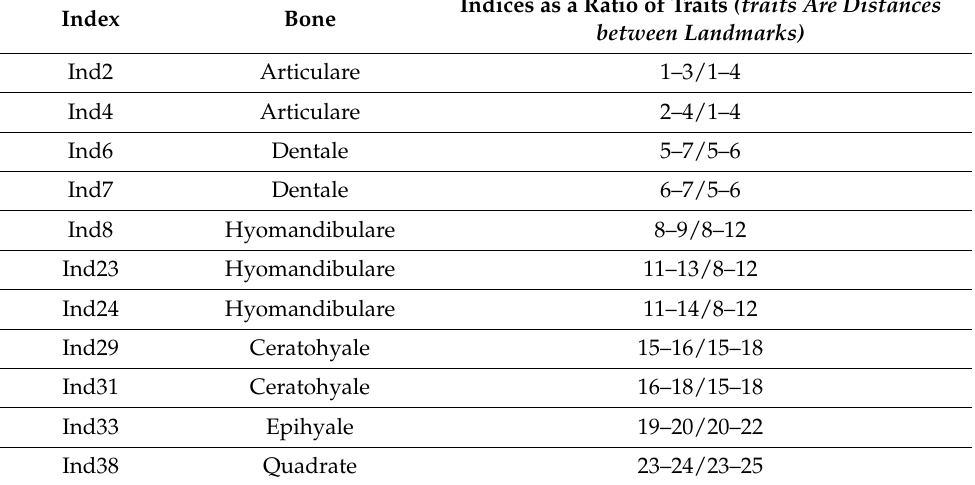
Table 2. Cranial bone indices that did not correlate with the body length in the six juvenile Atlantic salmon samples examined in this work (see Supplement Table S1 for the full list of traits and indices). Indices as a Ratio of Traits (traits Are Distances Bone